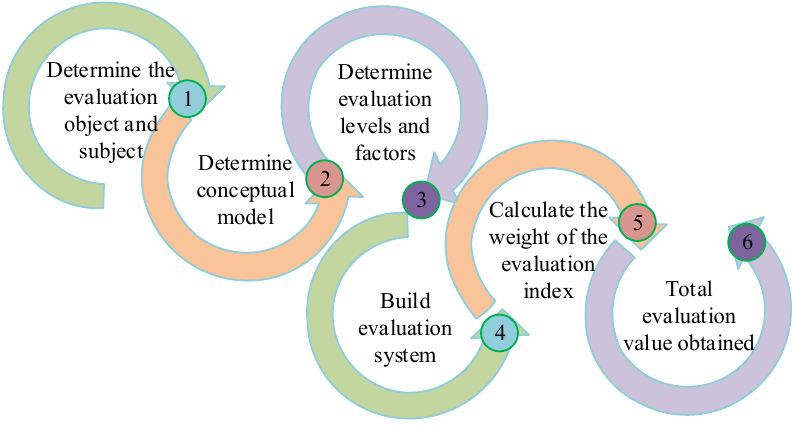
Figure 2. Overall Process of Evaluation Factor Method.